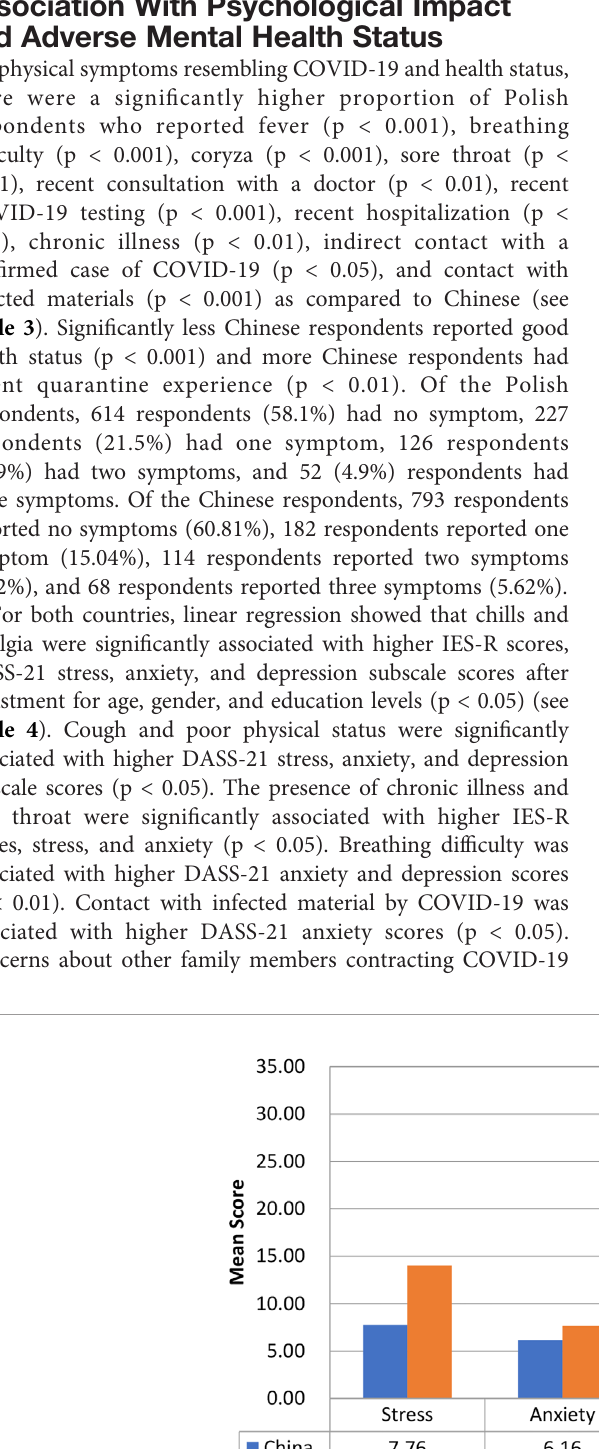
TABLE 1 | Comparison of demographic characteristics between Polish and Chinese respondents (N = 2,266).